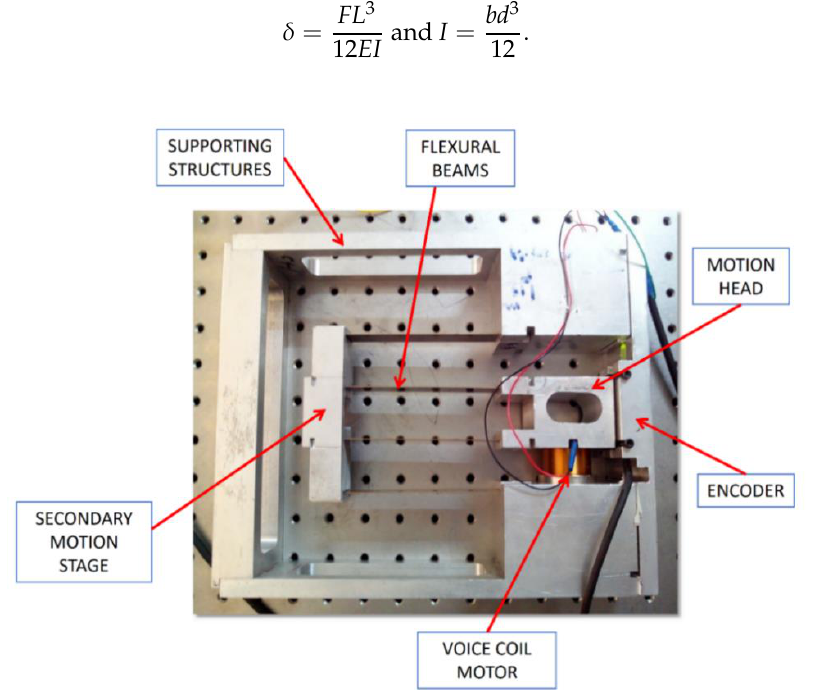
Figure 8. Manufactured DPF manipulator.